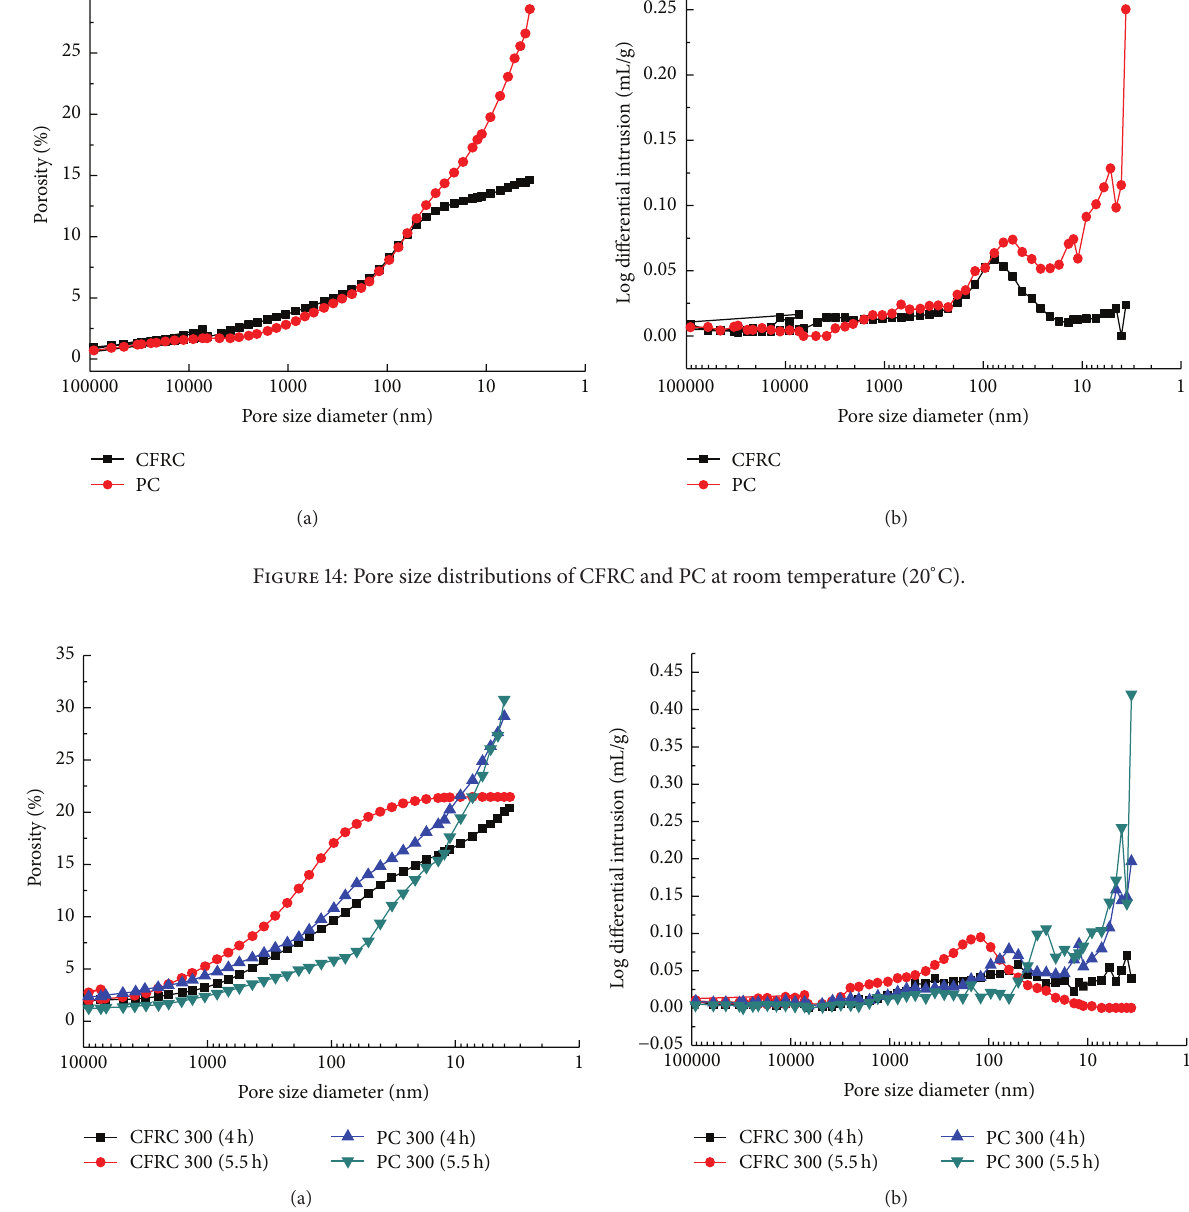
Figure 15: Pore size distributions of CFRC and PC after heating at 300 ∘ C for different holding times.